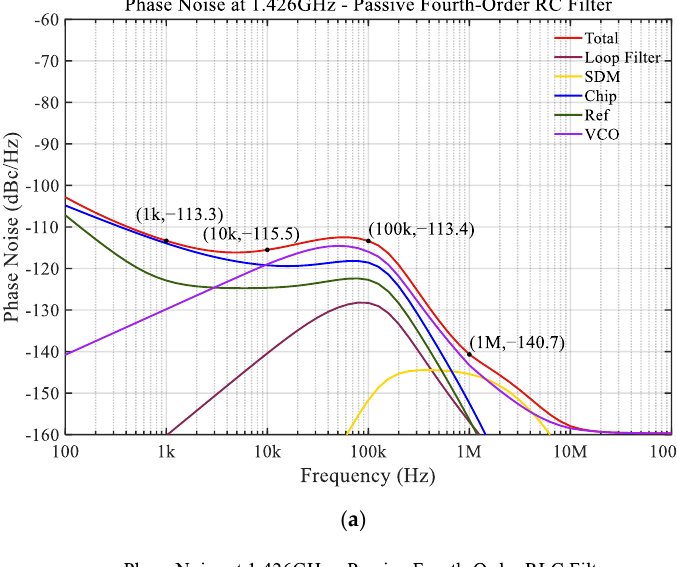
Table 4. Phase noise simulation results.